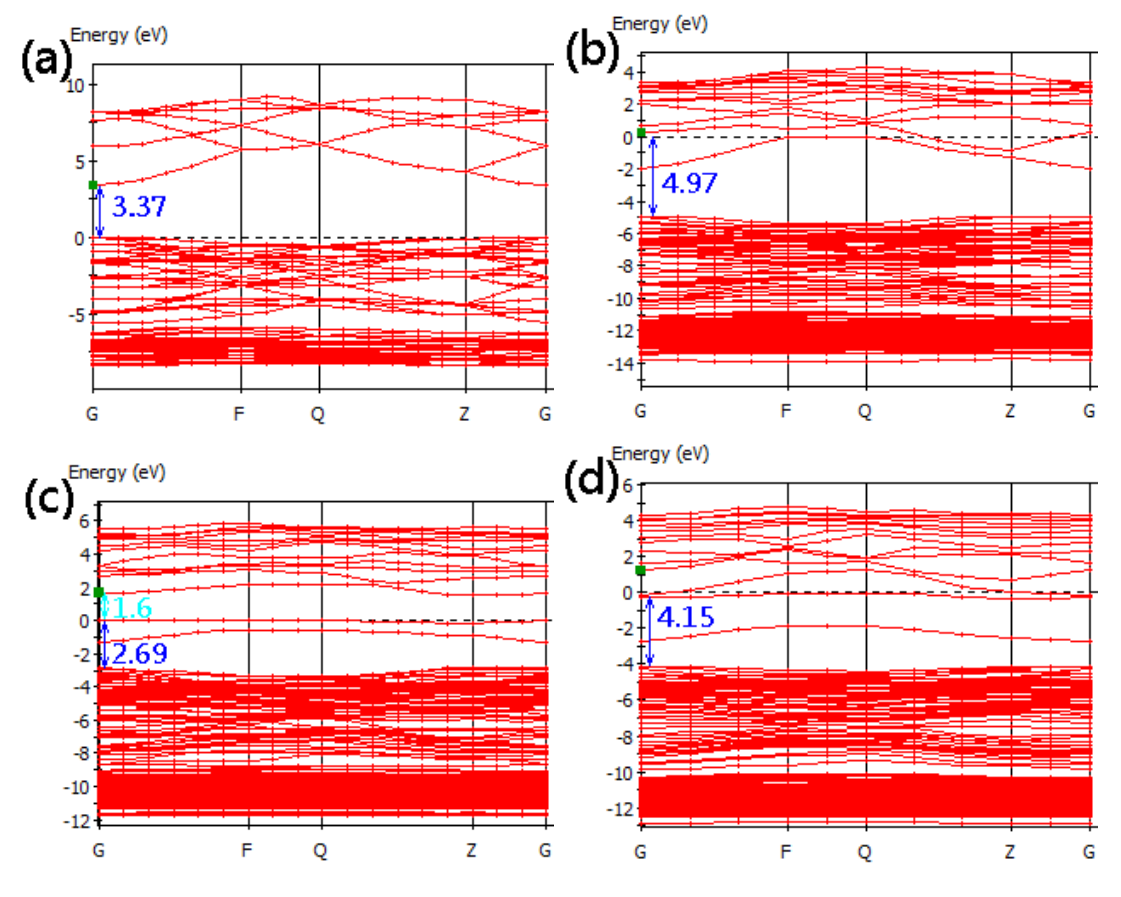
; ( c ) Si s(Zn) i(oct)